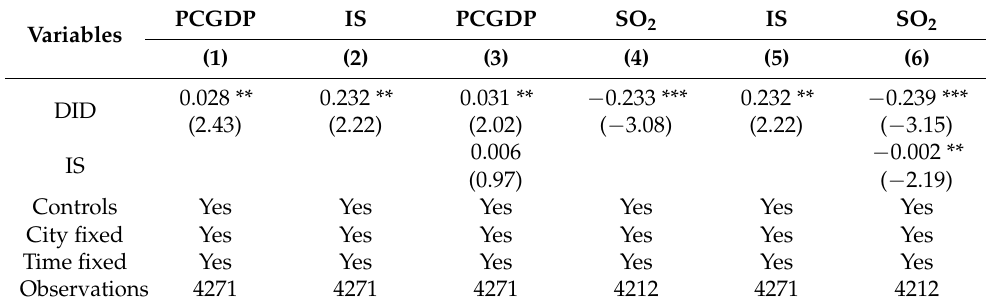
Table 10. Mediating effect of IS.